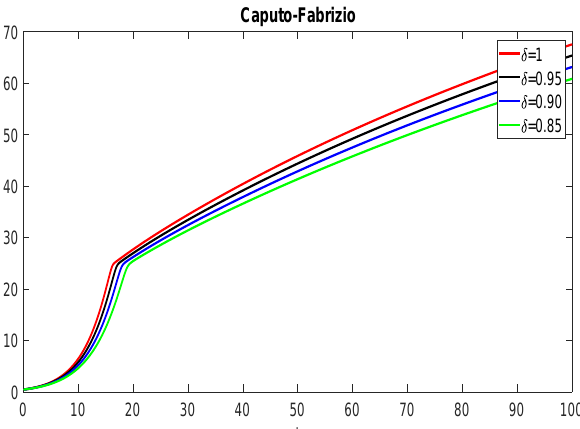
Figure 3. Evolution of the substrate, biomass, and ethanol for fractal dimension 0.8 and different fractional orders in Caputo–Fabrizio sense.